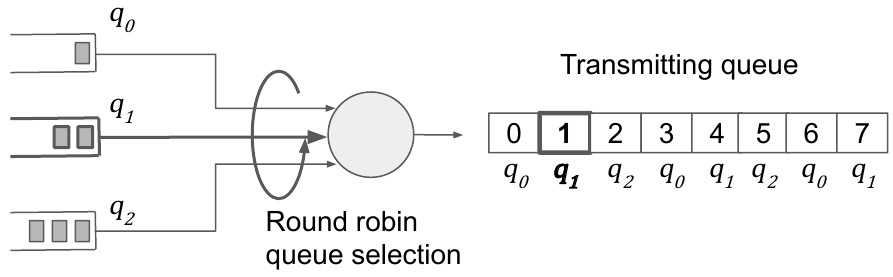
Figure 2. Mapping of cycle times to queues in the CSQF